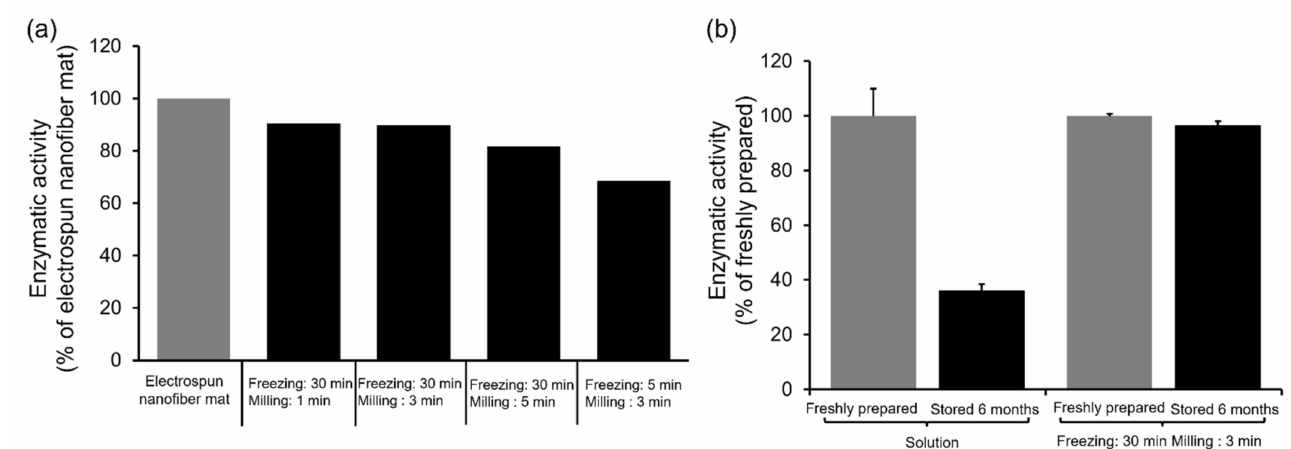
Figure 3. Assessment of the enzymatic activity of α -chymotrypsin ( α -Chy) via the determination of p-nitrophenol amounts. ( a ) Enzymatic activity of α -Chy-loaded polyvinyl alcohol (PVA) nanofiber mats milled by cryo-milling ( n = 1). The vertical axis indicates the activity of the α -Chy-loaded PVA nanofiber mat. ( b ) Long-term stability of α -Chy ( n = 3, mean ± standard deviation [SD]). The milled nanofiber mats that were frozen for 30 min and milled for 3 min and solutions containing α -Chy of the same composition were stored for 6 months and compared with freshly prepared ones regarding enzymatic